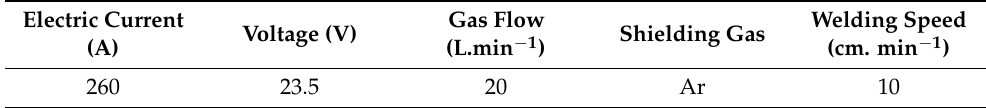
Table 4. Welding parameters of 316L stainless steel.